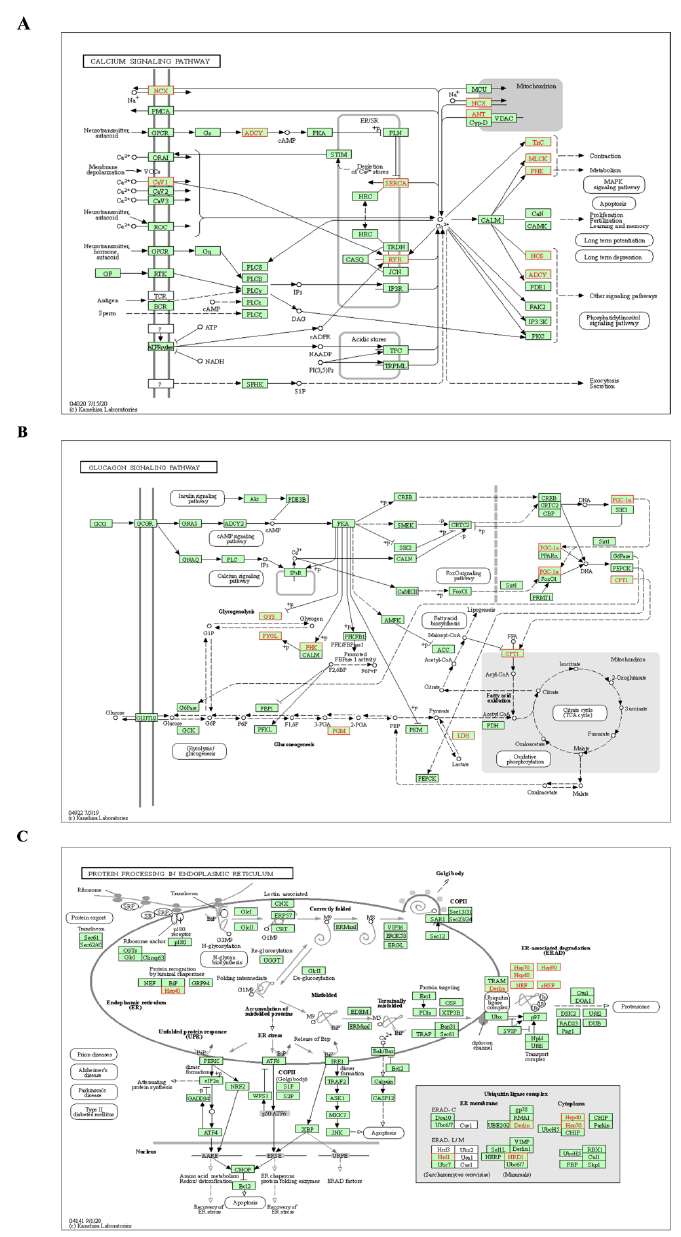
Figure 6. ( A ) Significantly enriched KEGG pathways in the calcium signaling pathway. ( B ) Significantly enriched KEGG pathways in the glucagon signaling pathway. ( C ) Significantly enriched KEGG pathways in protein processing in the endoplasmic reticulum. Upregulated DEGs are marked in red; pictures were drawn with KEGG Mapper (www.kegg.jp/kegg/tool/map_pathway2.html (accessed on 27 December 2021)).